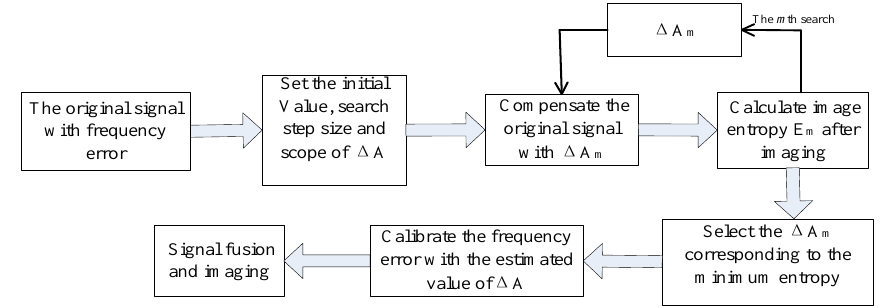
Figure 3. Flow chart of calibration method for frequency error based on entropy minimization principle.